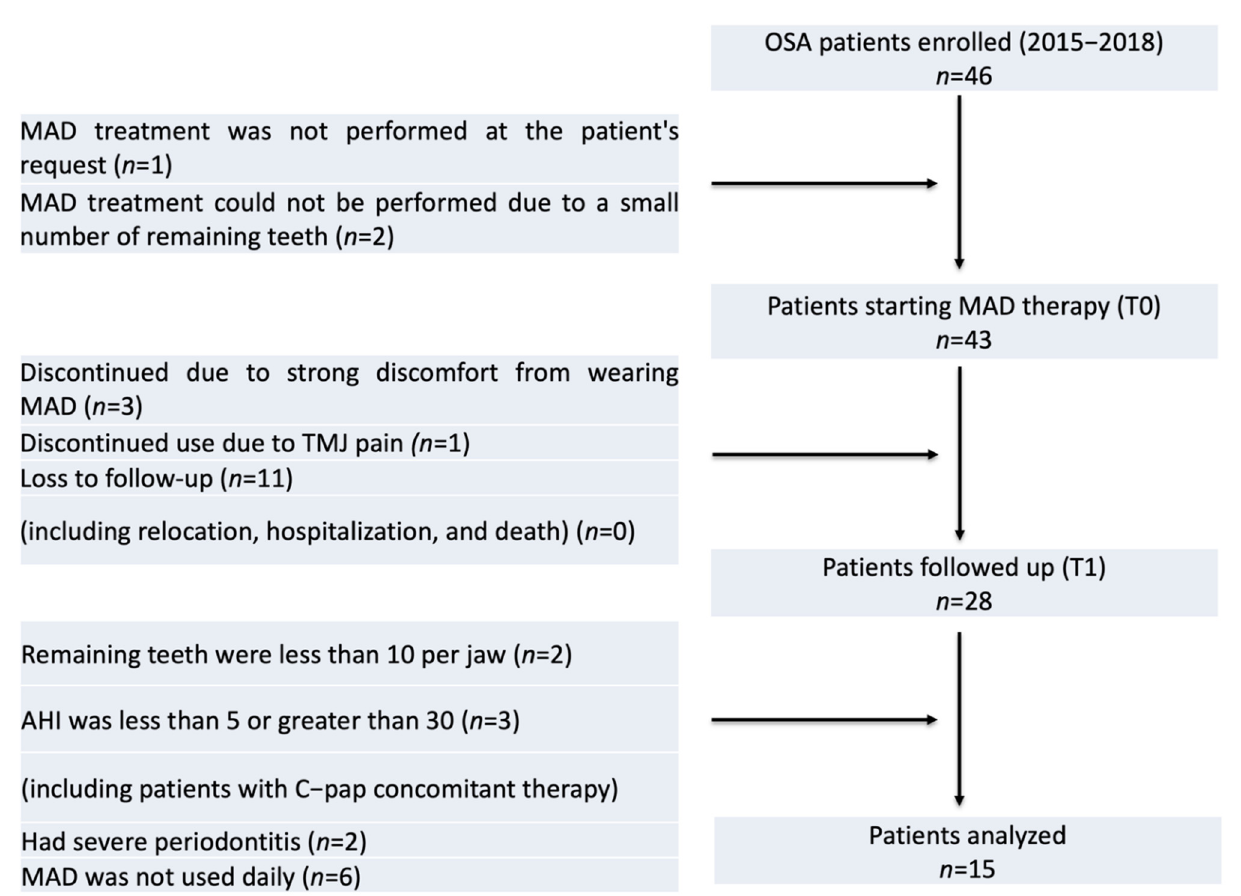
Figure 1. Flowchart illustrating the enrollment and the diagnosis procedure. OSA, obstructive sleep apnea; MAD, mandibular advancement device; TMJ, temporomandibular joint; PSG, polysomnography. Table 1. Inclusion and exclusion criteria of study participants. Inclusion Criteria Exclusion